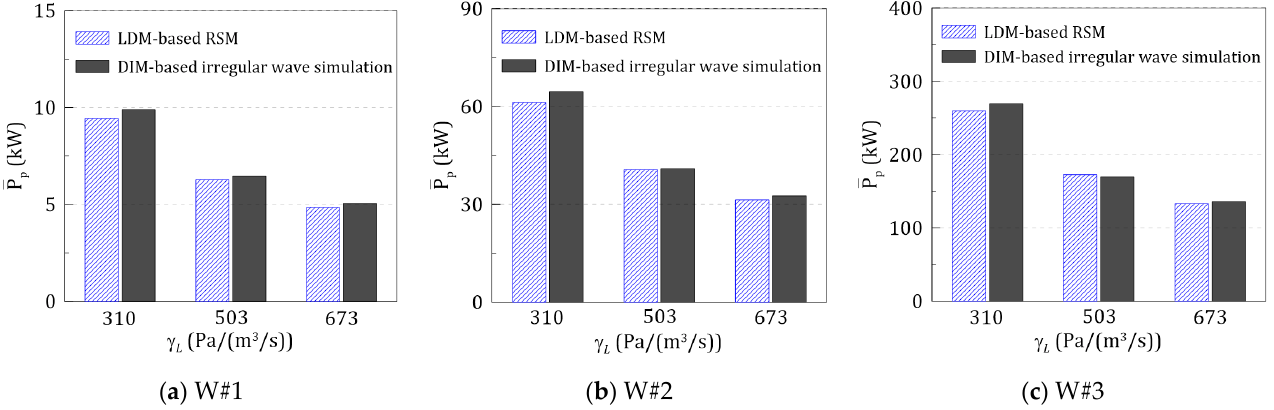
Figure 19. Comparison between the LDM-based RSM and DIM-based irregular wave simulation results for mean pneumatic power of the OWC chamber under irregular waves.